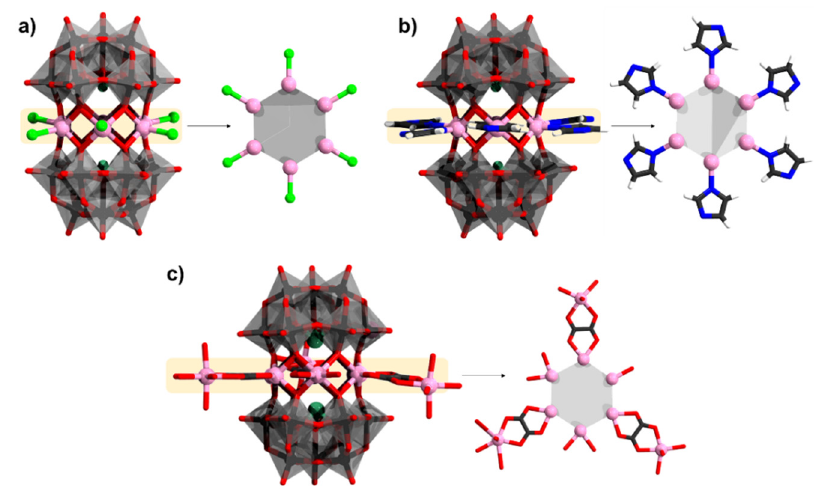
Figure 12. Polyanions and their heterometallic cores: ( a ) [(MnCl) 6 ( α -SbW 9 O 33 ) 2 ] 12 − ; ( b ) [Mn 6 (imi) 6 ( α -H 3 AsW 9 O 33 ) 2 ]; ( c ) [(Mn(ox)) 3 (Mn(H 2 O) 3 ) 3 (Mn(H 2 O) 2 ) 2 (Mn(H 2 O))( α -SbW 9 O 33 ) 2 ] 6 − . Color code: As/Sb = green, Cl = light green, Mn = pink, N = blue, H = white, C = dark gray, {WO 6 } = gray octahedra, W = black, and O = red. H atoms on aqua ligands are omitted.